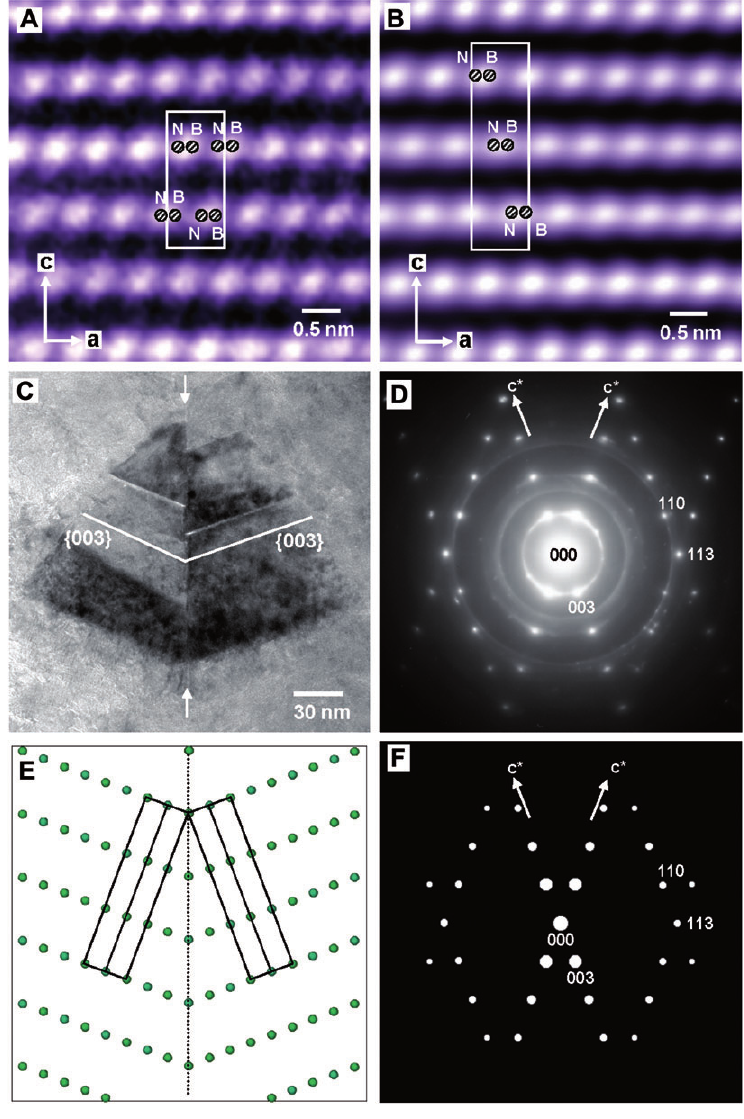
Figure 26 HREM images of (A) h-BN and (B) r-BN. (C) TEM image of twinned r-BN nanoparticle. (D) Electron diffraction pattern of (C), taken along [110]. (E) Atomic structure model of {113} twin structure of r-BN along [110]. (F) Calculated electron diffraction patterns of twin structure of